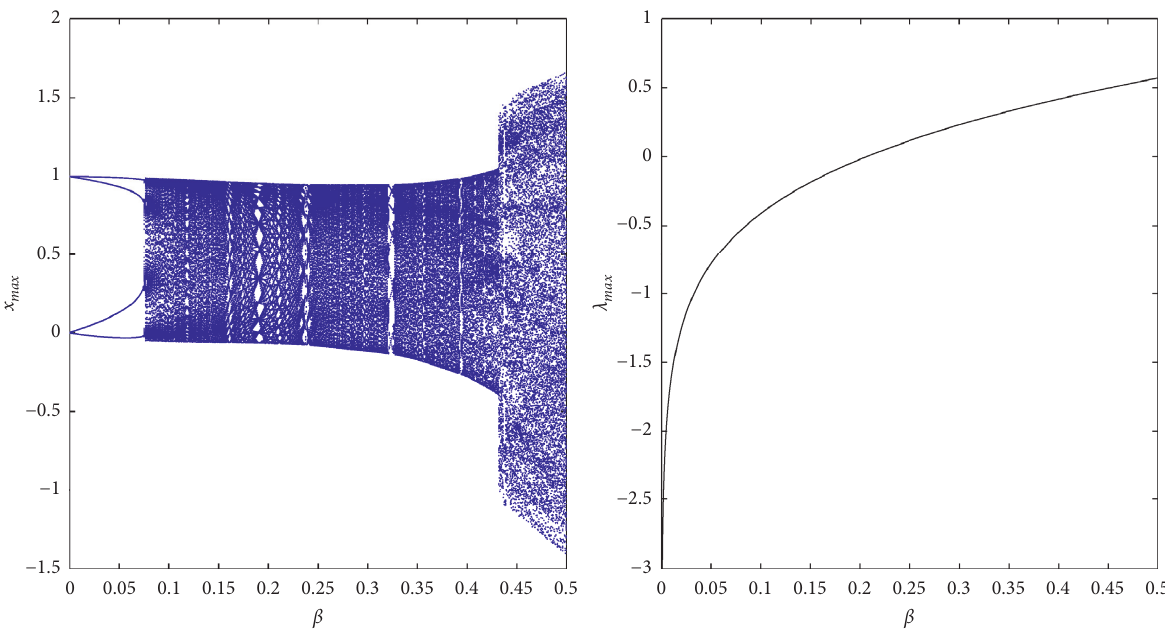
Figure 2: Bifurcation and largest Lyapunov exponent plots versus system parameter β for fractional order ] � 0 .